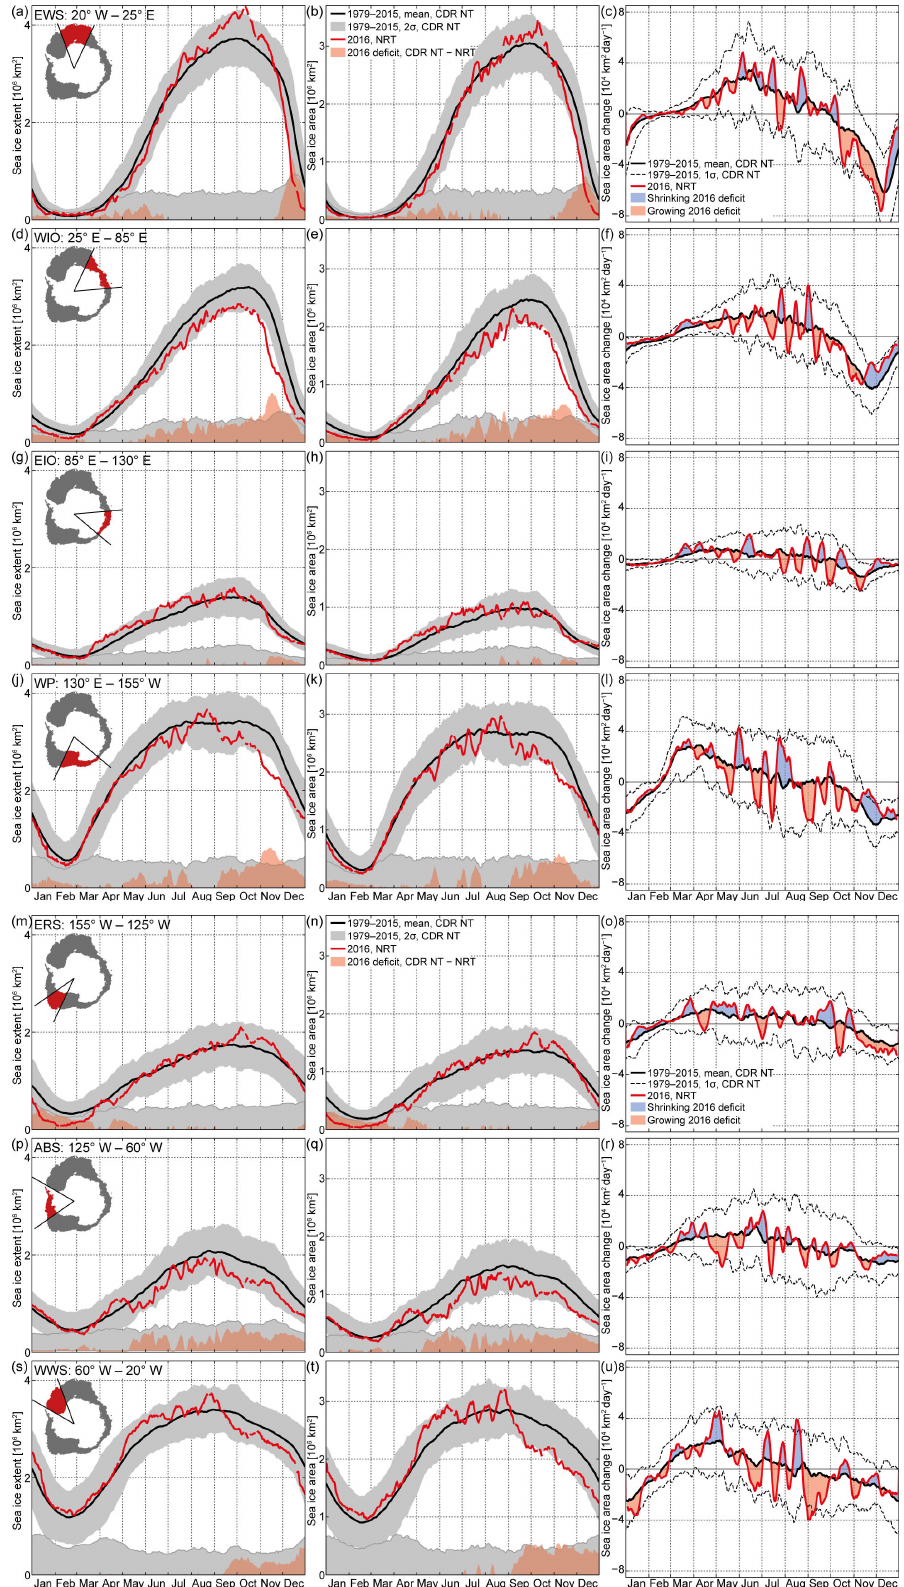
Figure 5. As Fig. 2, but for each of the seven regions separately. Regions are indicated in the inset map and Fig. 3 and are defined in Table 1. The Cryosphere, 12, 1103–1119, 2018